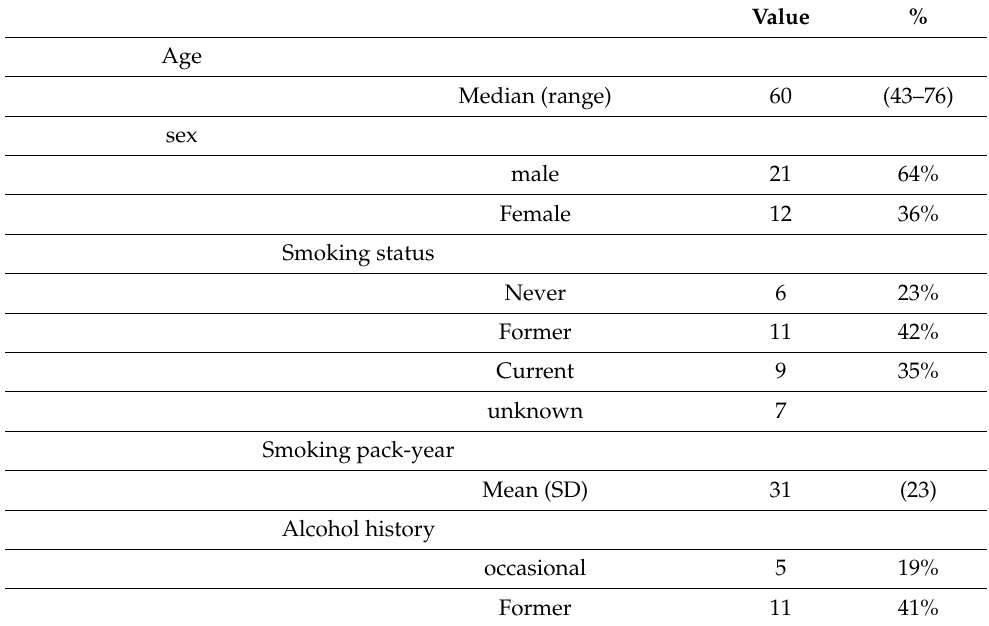
Table 1. Patient